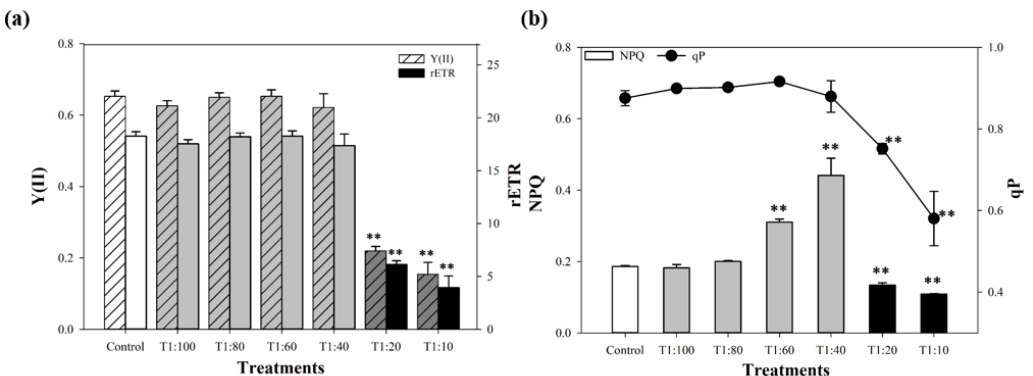
Figure 6. Photosynthetic system II parameters of Ulva prolifera under the exposure of different amounts of cell ‐ free filtrate of Bacillus cereus BE23: ( a ) quantum yield (Y(II)) and relative electron transport rate (rETR), and ( b ) non ‐ photochemical quenching (NPQ) and photochemical (qP). T 1:100 , and T 1:80 ~T 1:10 indicate the volume ratio of cell ‐ free filtrate of Bacillus cereus BE23 relative to f/2 medium in the different treatments. Values are means ± SD (n = 3). ** indicates a significant difference ( p < 0.001) compared to control.